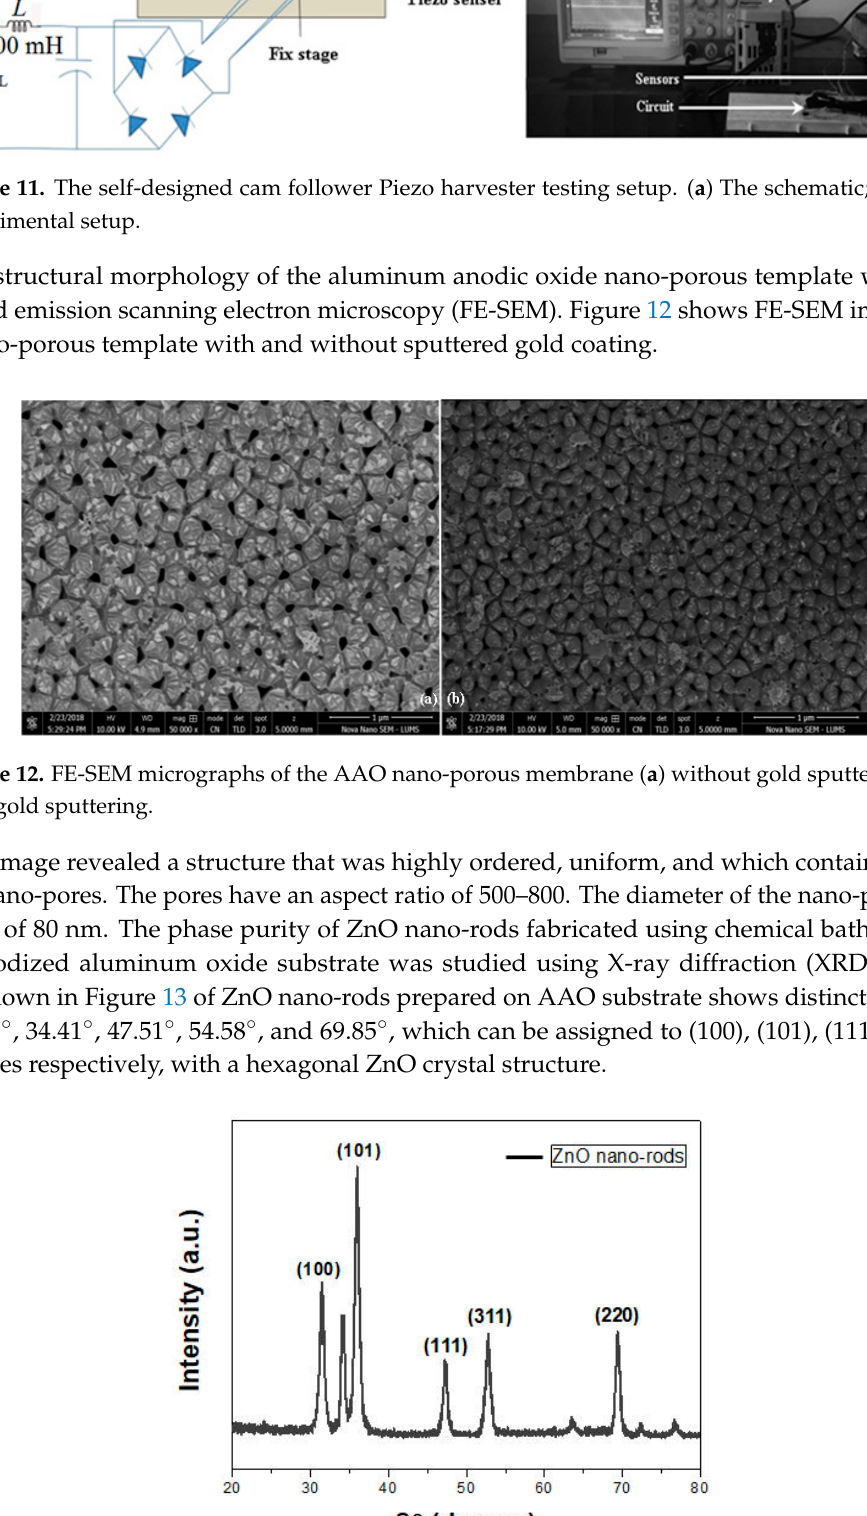
Figure 13. The X-ray diffraction pattern of ZnO nano-rods deposited on the AAO template.